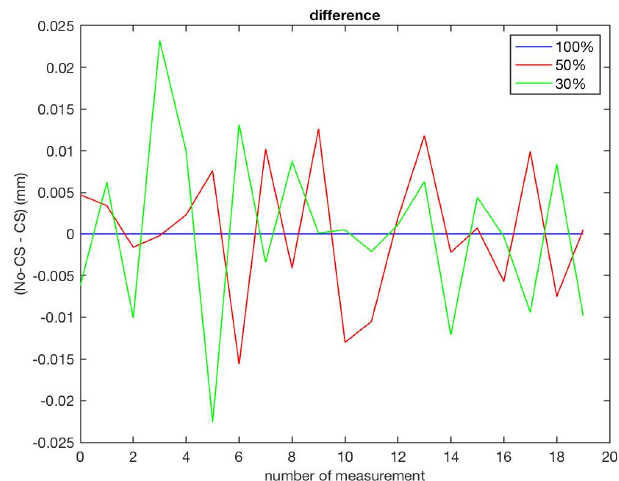
Figure 14. Differences between displacements detect through 100% CS, 50% CS, 30% and displacements detected using 100% of data without application of CS techniques (test site “Campus”).